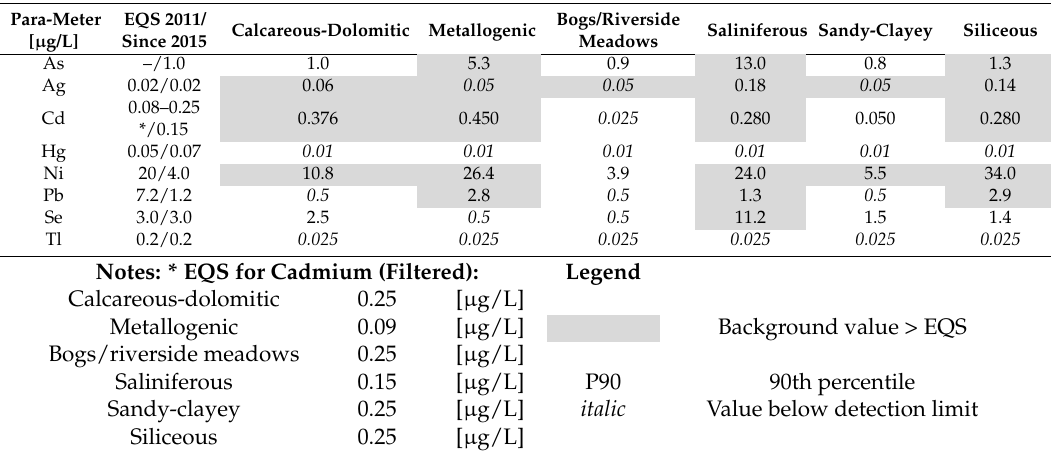
Table 6. Comparison of the P(90) values of the aggregated riverine landscapes with the EQS of the Surface Waters Ordinance of Germany (OGewV); results of the filtered water phase. Para-Meter [ µ